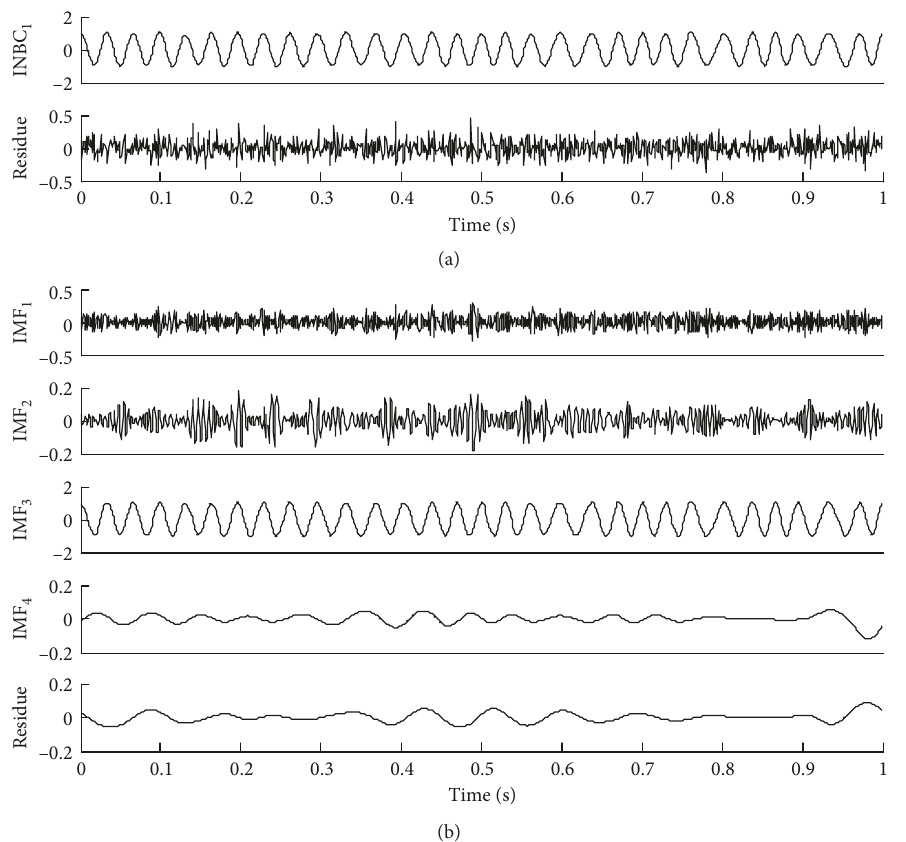
Figure 9: The decomposition results generated by ASNBD and EMD of simulation signal x 2 ( n ) shown in Figure 6(c) (SNR (cid:29) 15). The decomposition results of (a) ASNBD; (b) Table 2: Evaluating parameters of the components of x 2 ( n ) generated by ASNBD and EMD. Method SNR r 1 E 1 IO T (s) ASNBD